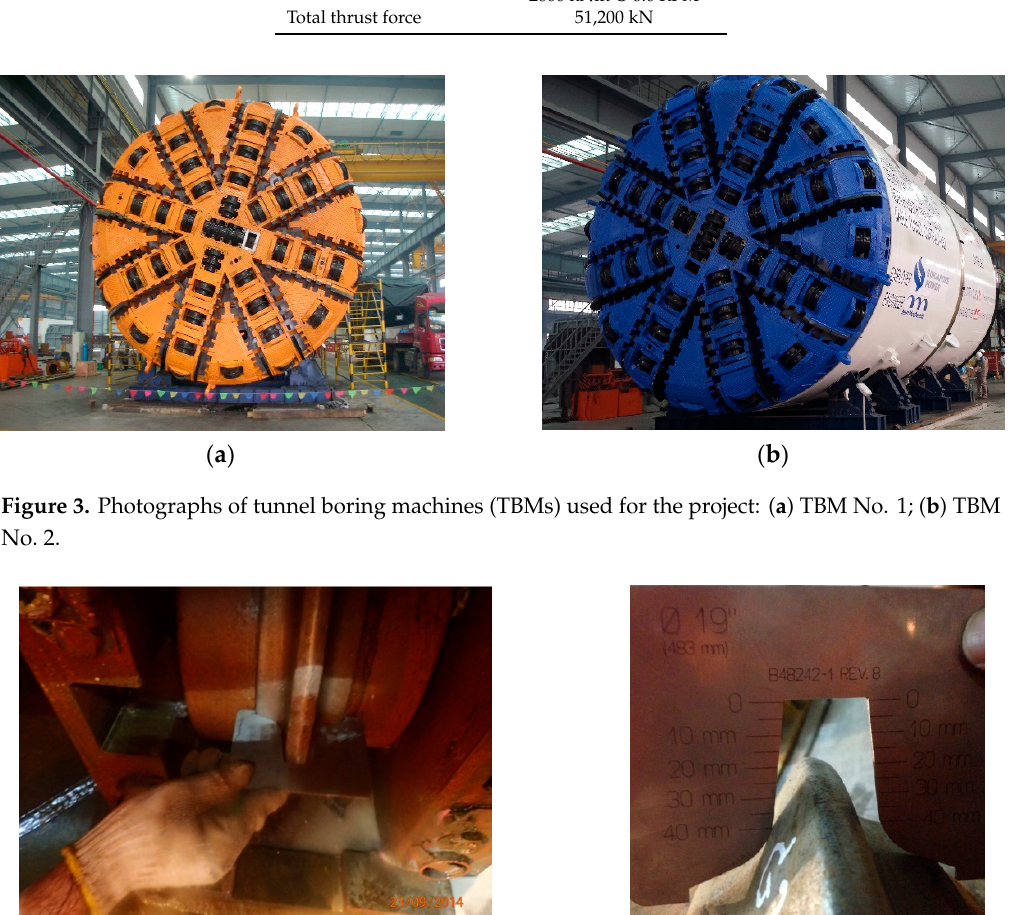
Figure 4. Measurement of wear of disc cutters: ( a ) during cutterhead interventions; ( b ) wear measuring ruler.